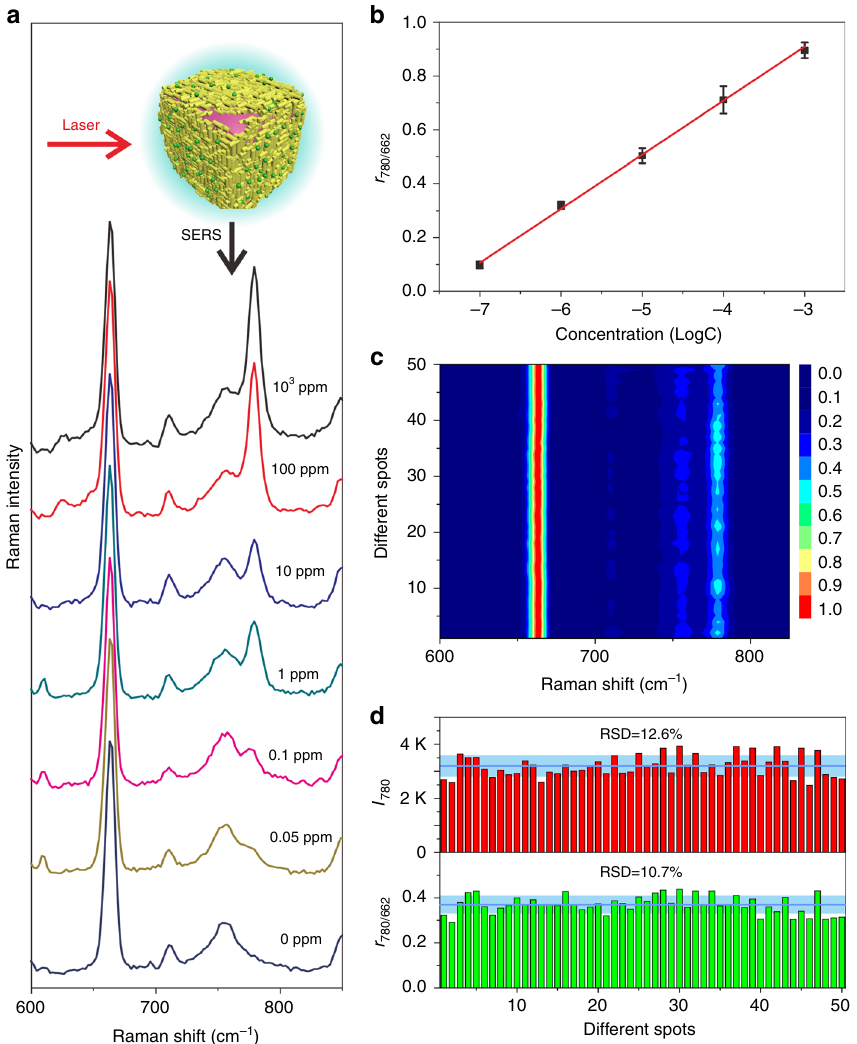
Fig. 6 Metal liquid-like GNR arrays on O- in -W interface for SERS analysis of TBZ. a SERS spectra of TBZ with concentrations of 0, 0.05, 0.1, 1, 10, 100, and 1000 ppm, respectively, dissolved in the O phase. b A linear relationship between the r 780/662 values and logarithmic TBZ concentration. c Fifty random runs in triplicate SERS experiments generating a 2D spectral mapping of 10 ppm TBZ. d Statistical histograms of r 780/662 and I 780 values, respectively. The error bars represent the statistical RSD and were calculated from fi ve different